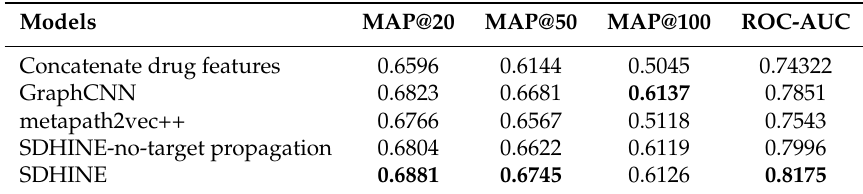
Table 6. DDI type identification performance comparison.